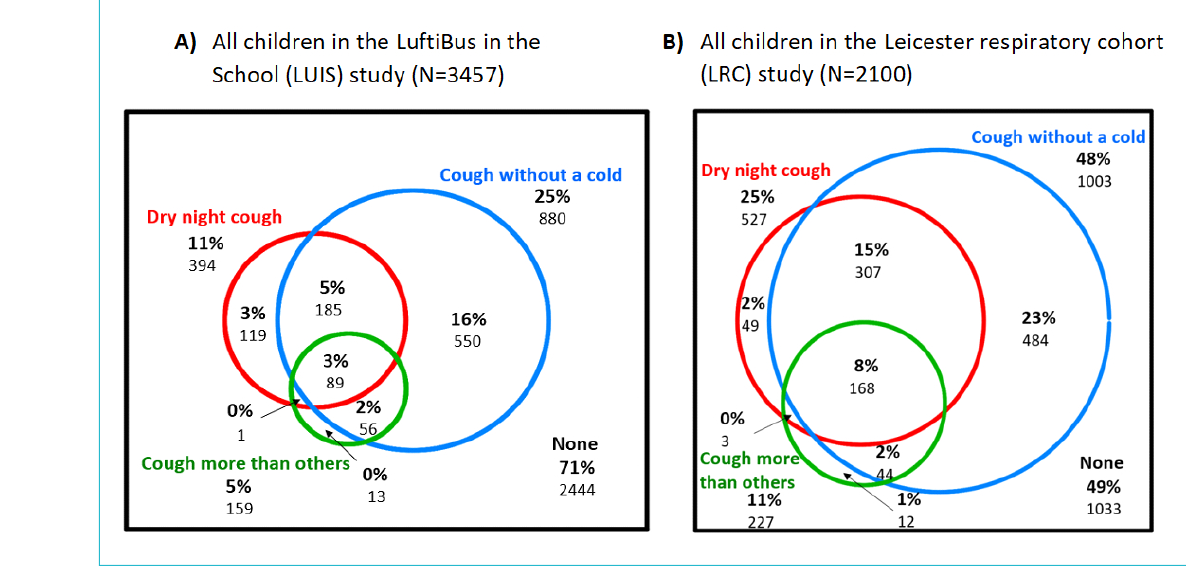
Figure 1: Venn diagram showing the overlap between parents’ answers to three different questions on cough in the LuftiBus in the school study and the Leicester respiratory